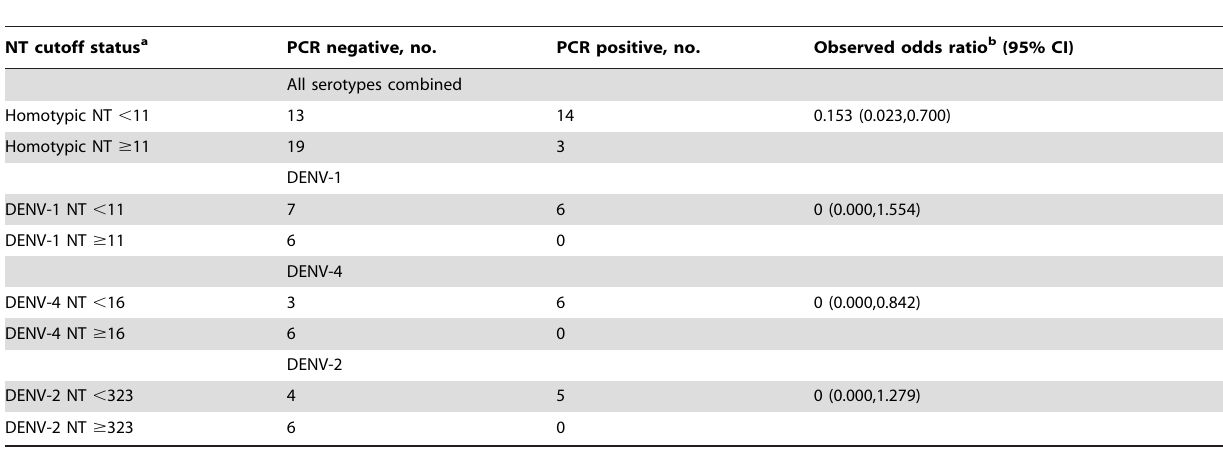
Table 4. Contingency tables showing relationship between homotypic neutralizing antibody titer cutoff values and dengue PCR